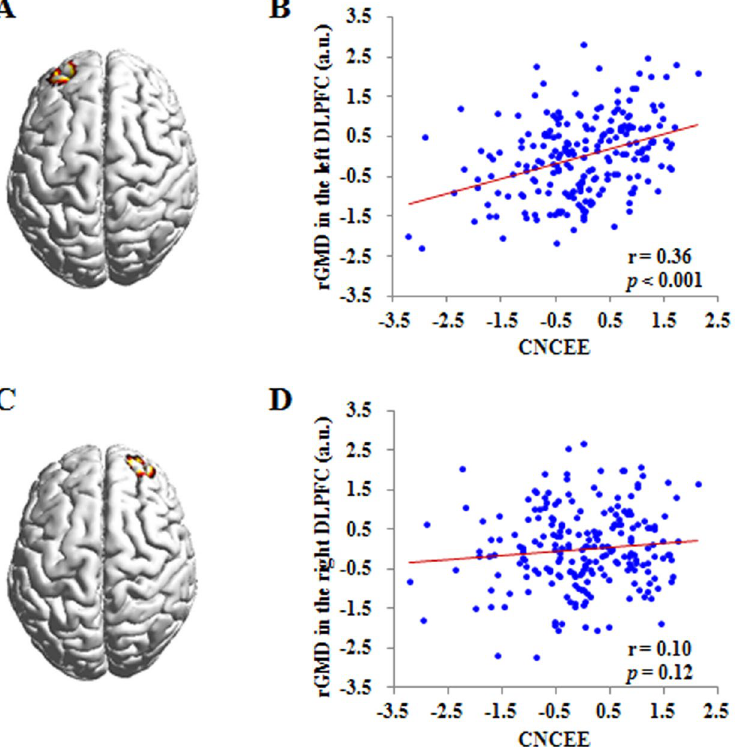
Figure 3. Correlation between CNCEE and the rGMD in the left DLPFC and right DLPFC. ( A ) Brain image showing the spherical region of interest (ROI, radius = 10 mm) in the left DLPFC, which was created by using the coordinate of peak ( − 30, 58, 28) in the significant region related to CNCEE from the whole-brain regression analyses. ( B ) Scatter plot depicting the correlation between CNCEE and the rGMD of the left DLPFC (r = 0.36, p < 0.001). The score of horizontal axis represents the standardized residual of the CNCEE score (average standardized score of four curriculum subjects) after adjusting for age, gender and total gray matter volume. The score of vertical axis represents the standardized residual of the rGMD in the left DLPFC after adjusting for age, gender and total gray matter volume. ( C ) Brain image showing the spherical ROI (radius = 10 mm) in the right DLPFC, which was created by using the coordinate of peak (30, 58, 28) in contrast to the left DLPFC. ( D ) Scatter plot depicting the correlation between CNCEE and the rGMD of the right DLPFC (r = 0.10, p = 0.12). The score of horizontal axis represents the standardized residual of the CNCEE score (average standardized score of four curriculum subjects) after adjusting for age, gender and total gray matter volume. The score of vertical axis represents the standardized residual of the rGMD in the right DLPFC after adjusting for age, gender and total gray matter volume. rGMD = regional gray matter density; DLPFC = dorsolateral prefrontal cortex; a.u. = arbitrary unit; CNCEE = Chinese National College Entrance Examination.